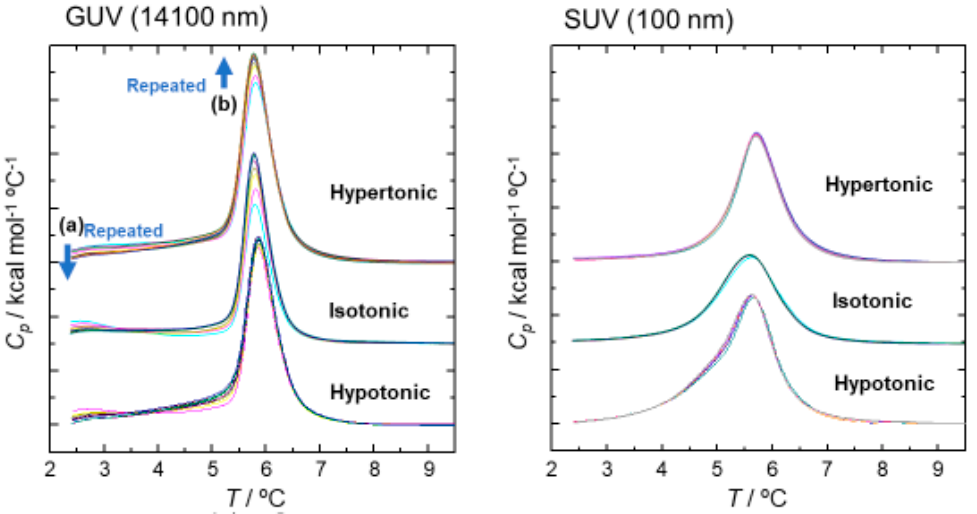
Figure 8. Effect of osmotic pressure on the DSC peak profiles of SOPC vesicles. DSC peaks are recorded for a repeated freeze-and-thaw process (5–8 times). Osmotic pressures (mOsm) are 112 for hypertonic, 56 for isotonic, and 14 for hypotonic. Arrow (a) indicates the diminution of the trace of the ripple phase, and arrow (b) shows the incremental height of the phase transition peak.